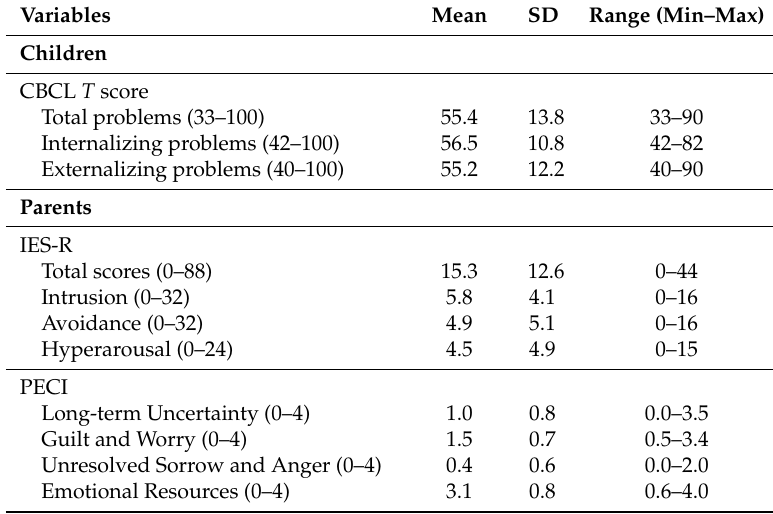
Table 2. Mean Child Behavior Checklist (CBCL), Impact of Event Scale-Revised (IES-R), and Parent Experience of Child Illness (PECI)